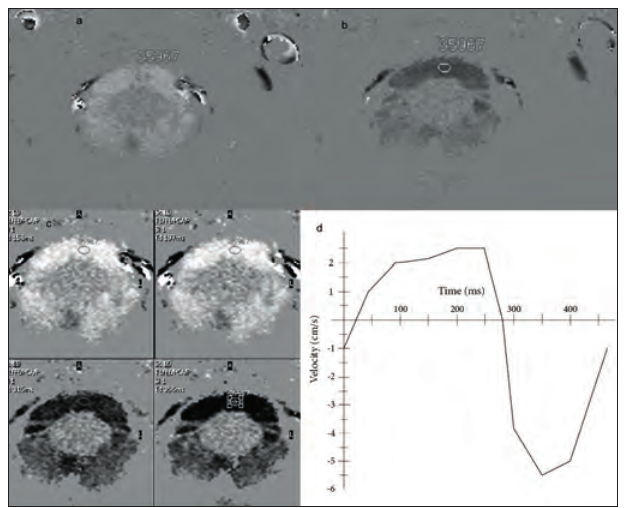
Fig. 3. Axial CSF flow study at the foramen magnum demonstrating normal bidirectional flow with graphic representation of a ROI in the anterior